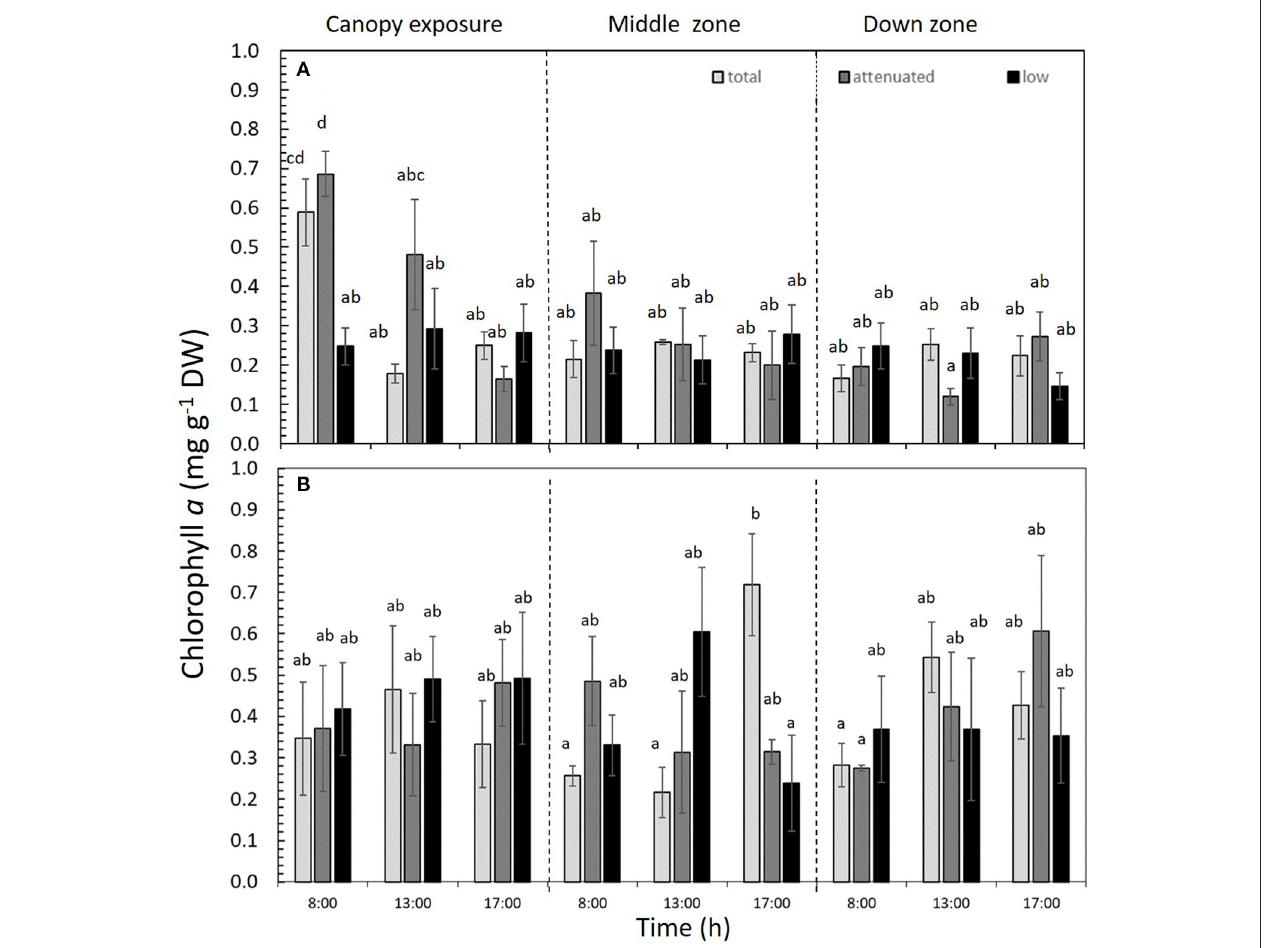
FIGURE 6 | Chlorophyll a (Chl a ) content in Macrocystis pyrifera fronds during the first daily cycle experiment (A) and the second daily cycle experiment (B) at three time points (8:00, 13:00, and 17:00h) in the total, attenuated, and low radiation treatments. Chl a was measured in three zones of the alga: canopy, middle, and down (mean ± SE, n = 3). Lower-case letters denote significant differences after the SNK test. TABLE 2 | Chlorophyll c1 + c2 , fucoxanthin ( Chl c 1 + c 2 and Fux , expressed in mg g − 1 DW) and antioxidant activity (AA%, in percent) during the 1DC and 2DC in the different solar irradiance treatments: total, attenuated, and low radiation at three times during the day. Total radiation Attenuated radiation Low radiation